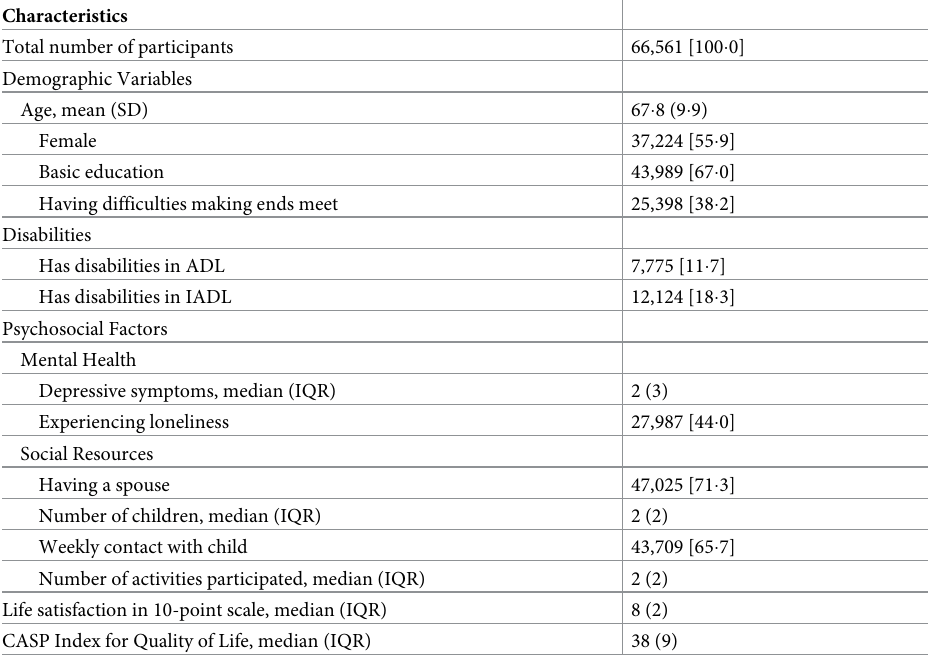
Table 1. Characteristics of the study